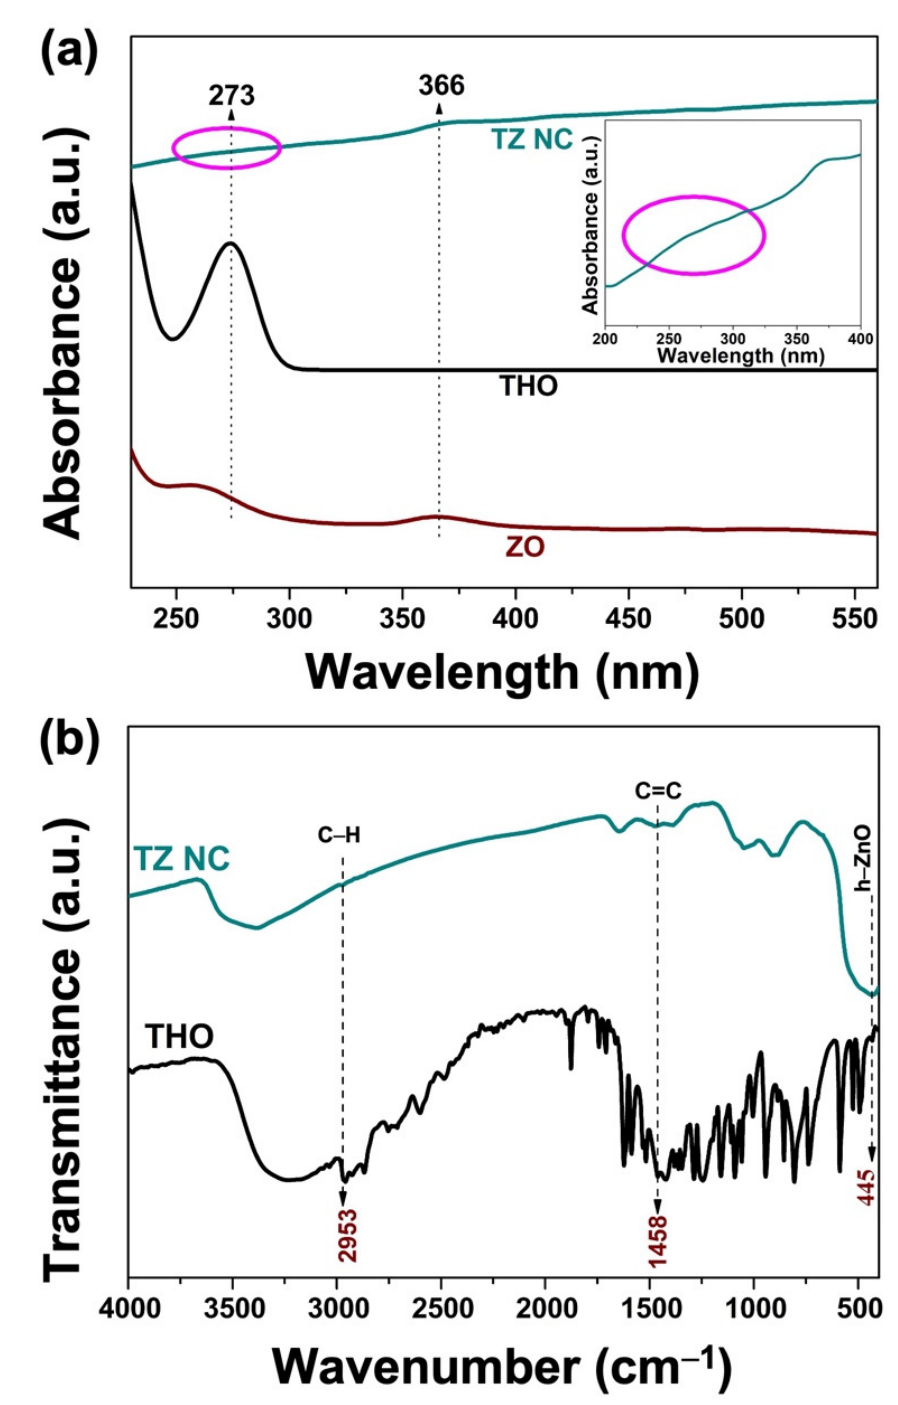
Figure 2. ( a ) UV–vis spectrum of THO, ZO, and TZ NC samples. Inset shows the enlarged spectrum (as marked) of TZ NC sample. ( b ) FT-IR spectrum of THO and TZ NC samples.